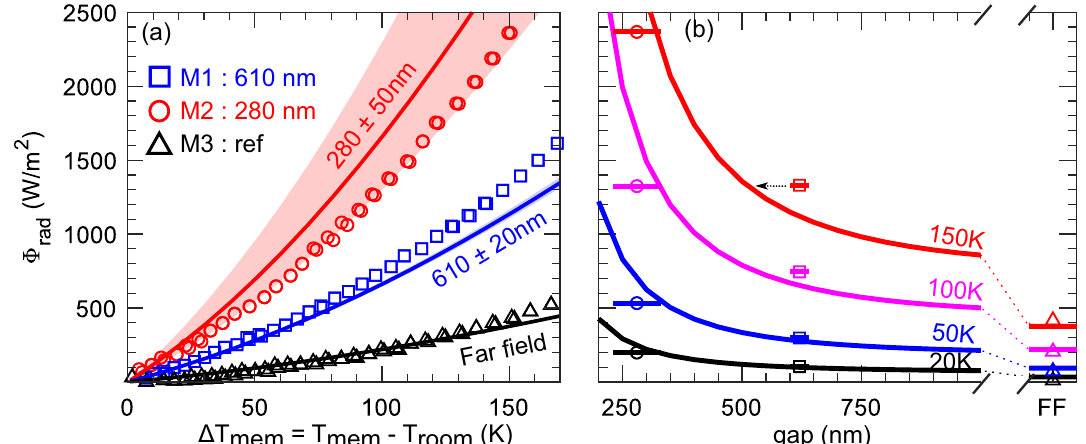
Figure 4. ( a ) Radiative heat flux VS membrane temperature rise. Points correspond to experimental data (M1: blue, M2: red, M3: black). Lines correspond to theoretical calculations for the mean gap and fill correspond to the uncertainty on the gap. ( b ) Radiative heat flux VS gap with the substrate for different temperature rises. Lines are the theoretical calculations and points are the experimental data ( (cid:31) M1 ; represent an eventual thermal buckling leading to a gap variation for high